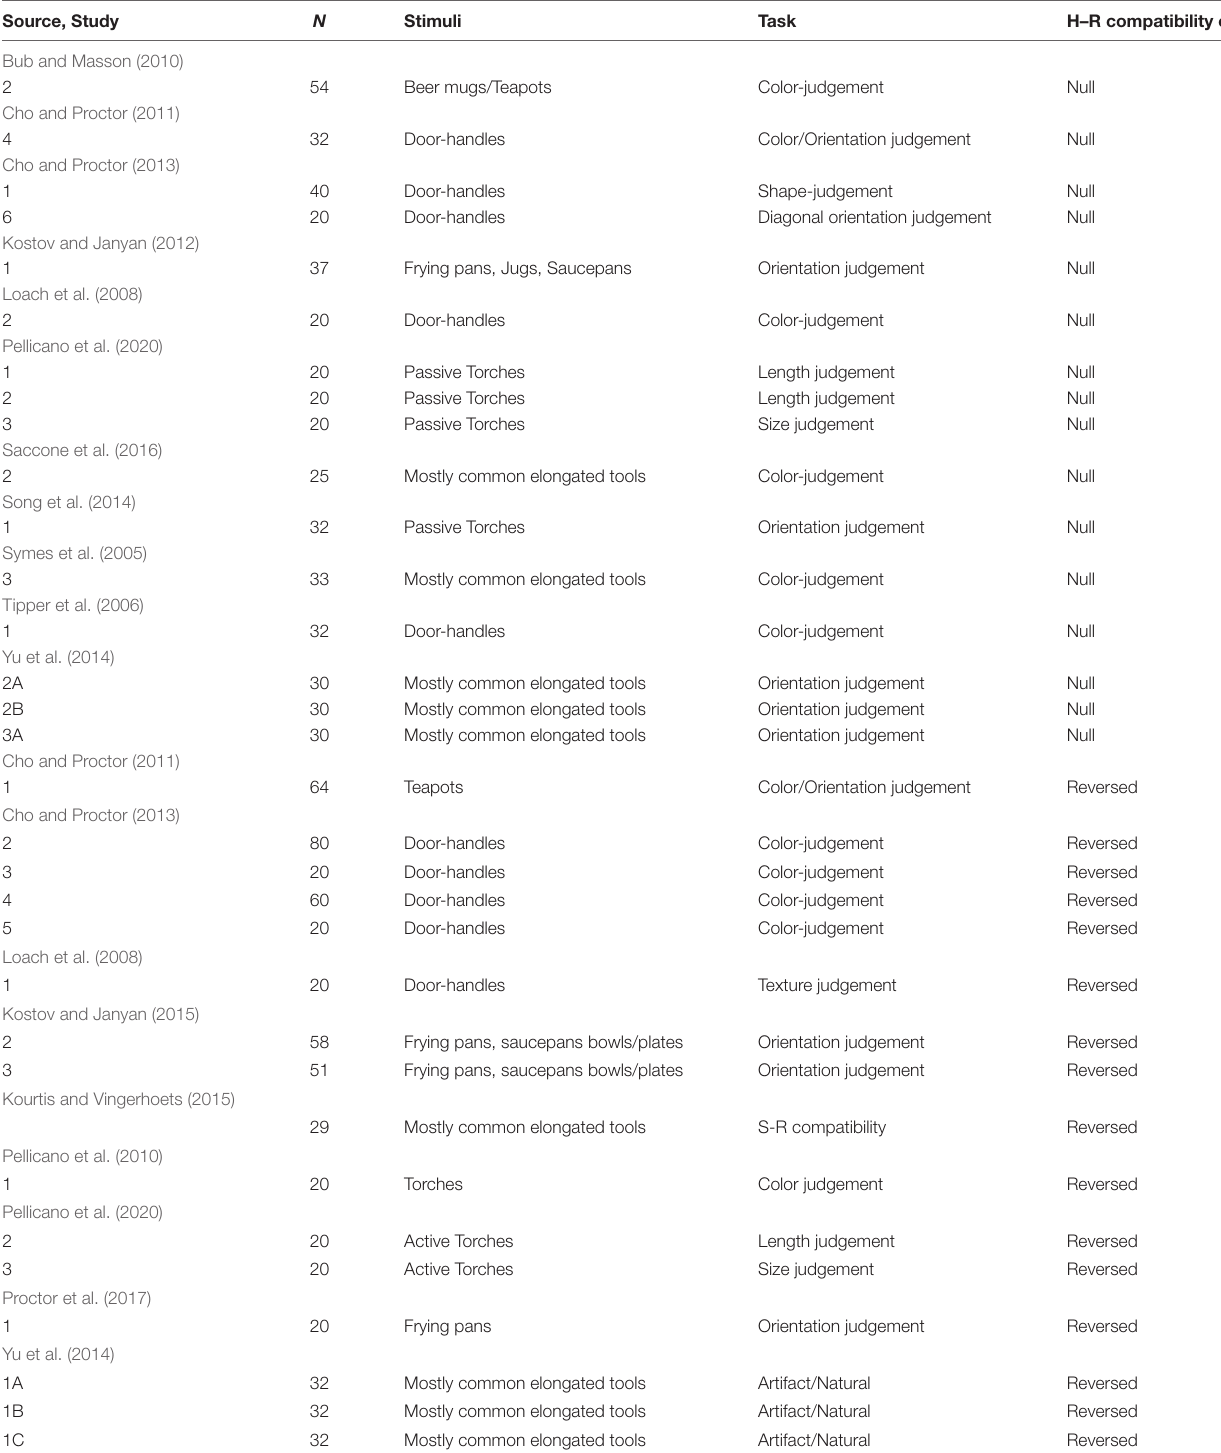
TABLE 1 | Prior known tests of the Handle–Response (H–R) compatibility effect showing null and/or reversed effects. Source,